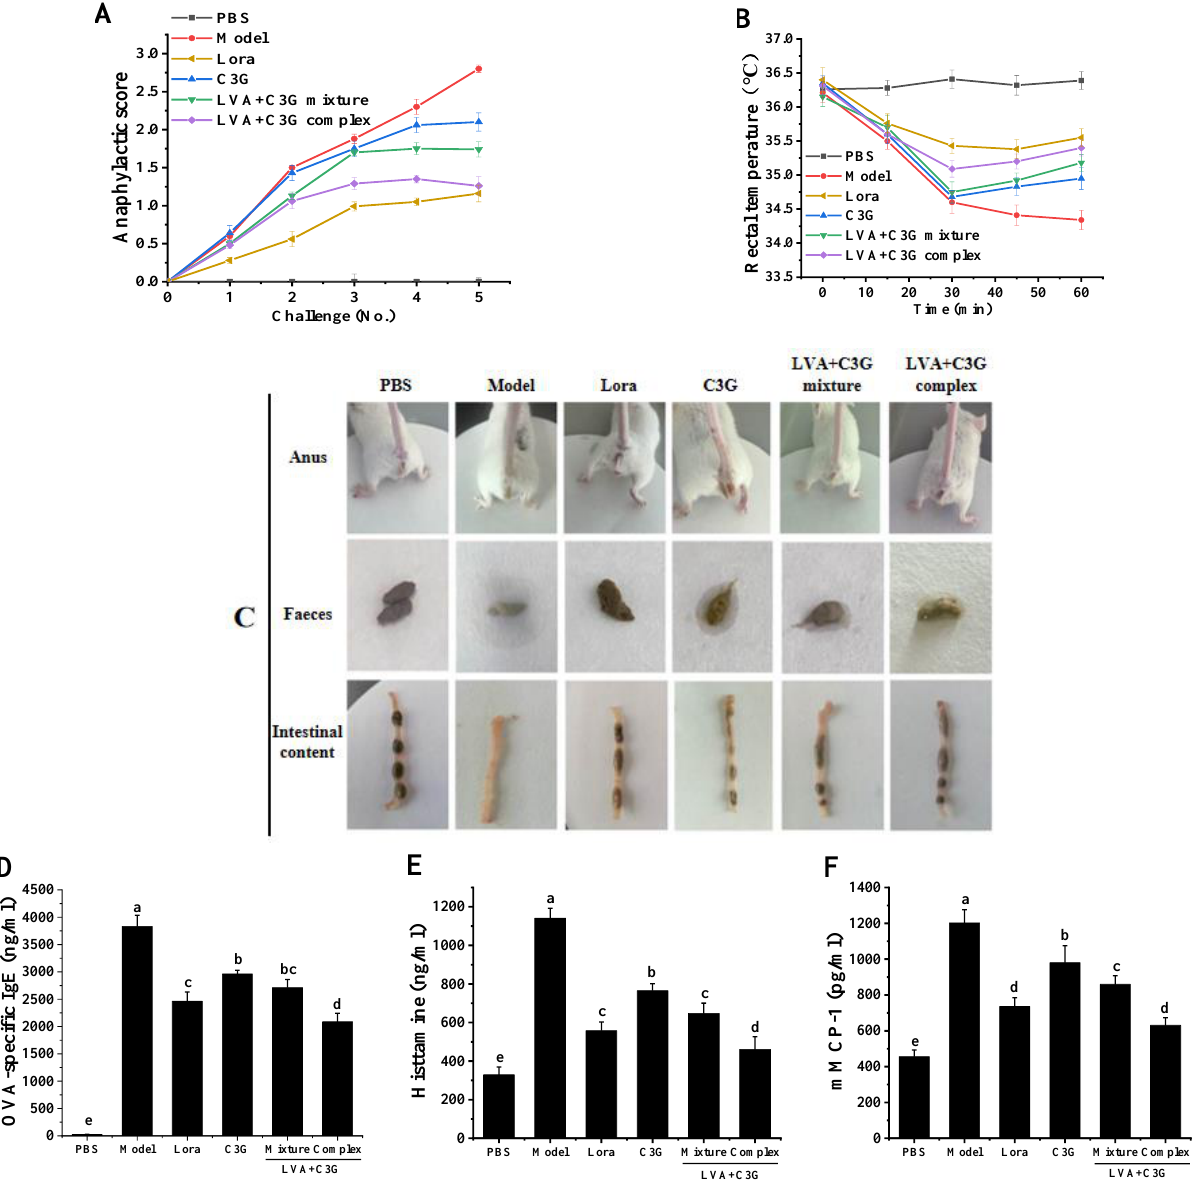
Figure 2. The effect of the C3G-associated samples on the allergic response. ( A ) The scores of the anaphylactic symptoms. ( B ) The rectal temperature of the mice 0 to 1 h after the last challenge. ( C ) Anal, fecal, and intestinal content observations. ( D ) Serum OVA-specific IgE. ( E ) Serum histamine. ( F ) Serum mMCP-. Significant differences ( p < 0.05) are identified by different letters. The serum OVA-specific IgE, histamine, and mMCP-1 levels were determined to further investigate the effect of C3G, the LVA + C3G mixture, and the LVA + C3G complex on anaphylaxis in OVA-induced allergic mice. As expected, the serum OVA-specific IgE, histamine, and mMCP-1 levels in the model group were exceedingly high, reaching 3833.53 ± 203.04 ng/mL, 1141.52 ± 51.61 ng/mL, and 1202.74 ± 73.01 pg/mL, respectively (Figure 2D). Contrarily, the serum OVA-specific IgE levels were significantly ( p < 0.05) reduced when the animals were treated with C3G, the LVA + C3G mixture, or the LVA + C3G complex. The LVA + C3G complex performed the best. Compared with the Lora group (35.7% reduction), a 45.6% reduction in the OVA-specific IgE level was observed in the LVA + C3G complex group. Similarly, the LVA + C3G complex displayed a better ( p < 0.05) inhibitory effect on the serum histamine and mMCP-1 levels than both